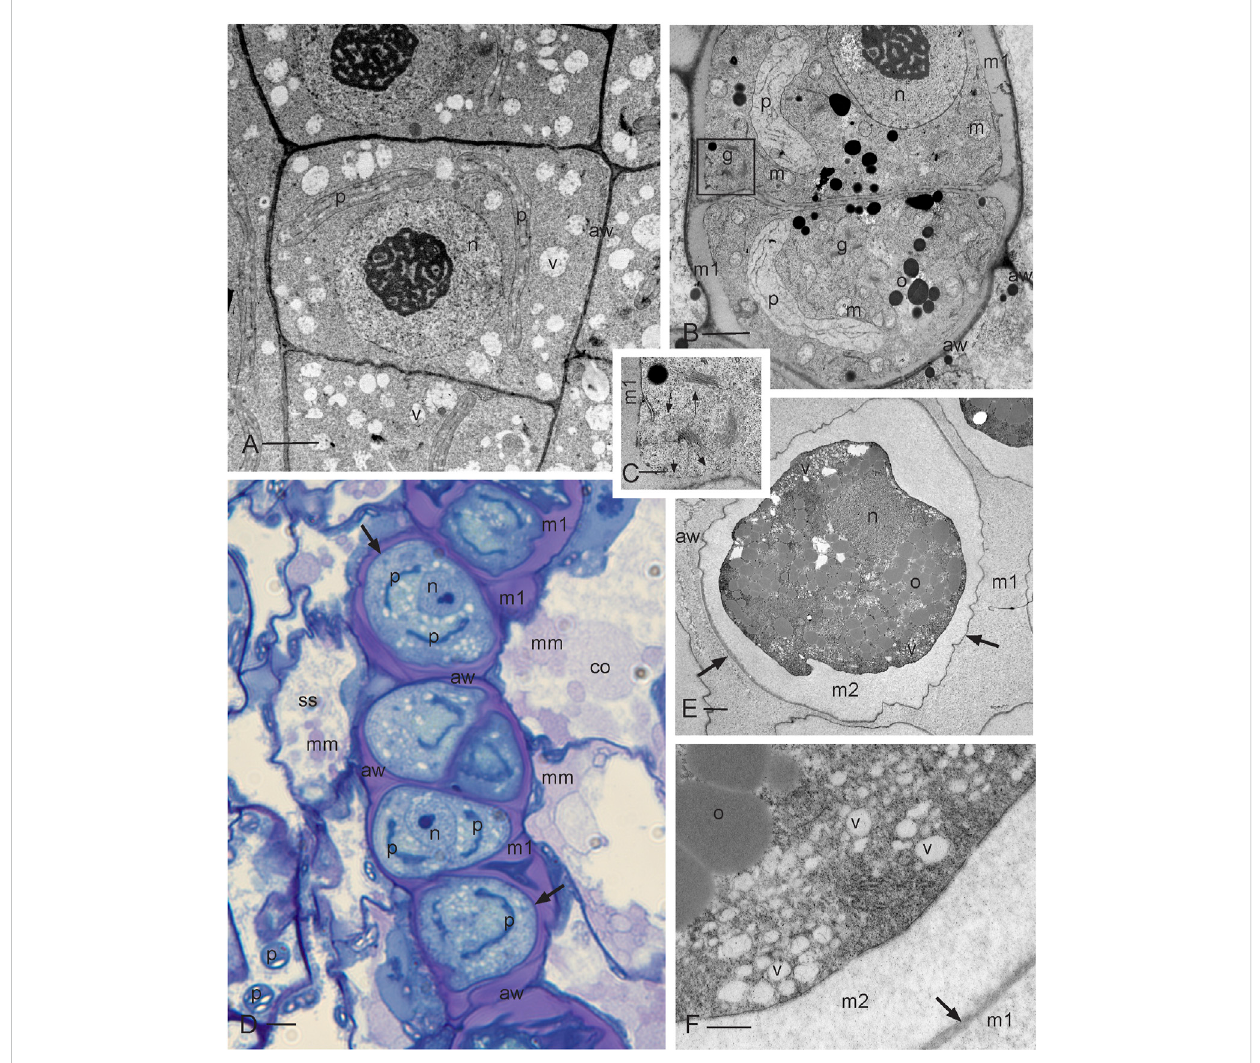
FIGURE 2 Development of sporogenous tissue. (A) Transmission electron microscope (TEM) image of archesporial cells showing thin walls (aw), a dense cytoplasm, and a large central nucleus (n) with prominent nucleolus and scattered vesicles (v). Two plastids (p) are migrating to the opposite poles in preparation for mitosis. (B) TEM of differentiating SMCs following the fi nal mitosis. Cells contain a large nucleus (n), a single plastid (p), numerous mitochondria(m),oildroplets(o),andabundantGolgibodies(g)thatdepositcellwallmaterialthroughexocytosis,formingamatrix(m1)thatrounds and separates SMCs from each other and from archesporial cell walls (aw), theinner capsule wall (spore sac) and columella. (C) Enlargement of the Golgi apparatus in the box outlined in (B) showing Golgi vesicles (long arrows) and vesicles recently fused with the plasmalemma (short arrows) that deposit matrix 1 and rounds SMC protoplasts. (D) Light micrograph (LM) of the developing SMC layer in the archesporium surrounded by a spore sac (ss) (inner capsulewalllayer)andcolumella(co).Thematrixmaterial(mm)isdepositedbythesporesacandcolumellafurthercontributingtothelocularmatrix(m1) that surrounds and suspends spores during development. SMCs are delimited by a thin cell wall (arrows) and contain a large nucleus (n) and two plastids (p) that will undergo another round of division to produce four plastids in preparation for meiosis. The original archesporial cell walls (aw) are visible. (E) TEM of an SMC that is embedded in the locular matrix (m1) and has deposited a second matrix (m2) between the thin wall (arrows) and the protoplasm. Archesporial walls (aw) are disintegrating. The SMC contains dense cytoplasm, oil droplets (o), nucleus (n), and numerous peripheral vesicles (v). Plastids are not in the section. (F) Enlargement of SMC suspended in the locular matrix (m1) showing oil droplets (o) and numerous vesicles (v), containing a faint fi brillarmaterial,depositingtheextraprotoplasmicmatrix(m2)betweentheplasmalemmaandthethinSMCwall(arrow).Scalebars: (A,B,E) =2.0 μ m; (C, F) = 0.5 μ m; and (D) = 5.0 μ